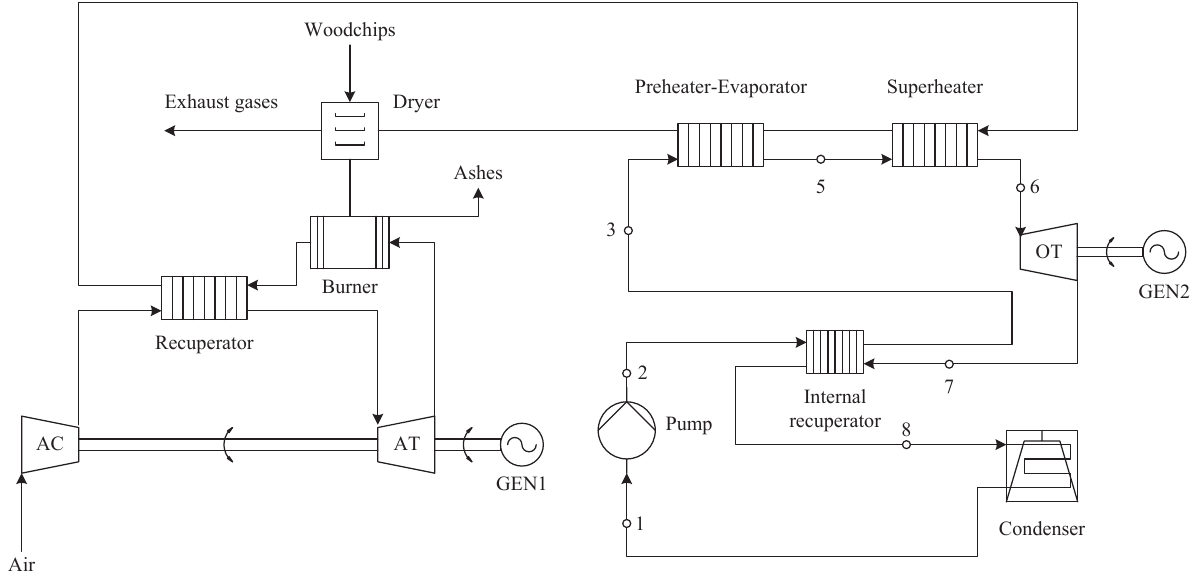
Plant configuration composed of ( left ) the wet indirectly fired gas turbine (WIFGT) and ( right ) the organic Rankine cycle (ORC) power module